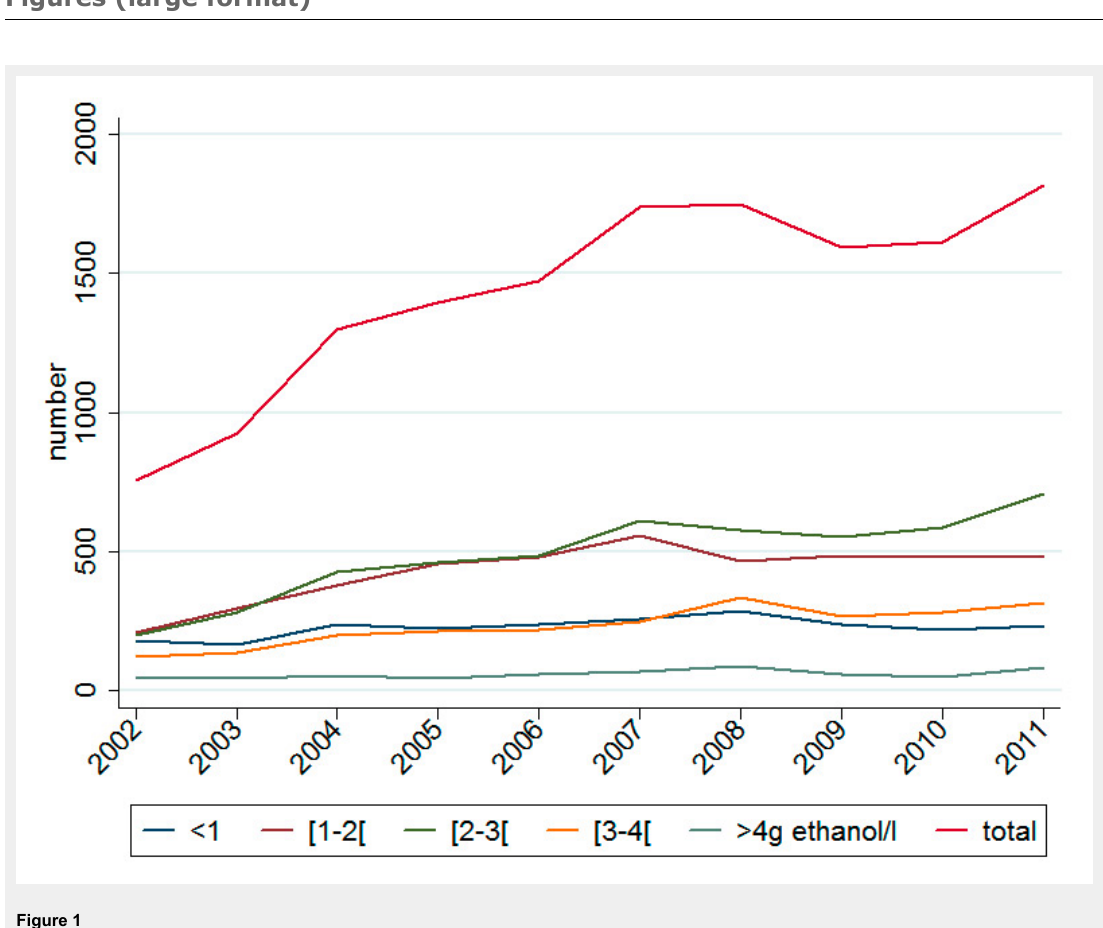
Total number of positive BAC ≤1, >1 to ≤2, >2 to ≤3, >3 to ≤4, >4 permille (g of ethanol per liter) over time. BAC: blood alcohol concentration A significant increase in the percentage of admissions with a positive BAC was observed over time (robust regression, coefficient (SE) for each year of observation = 0.0022 (0.0009), p = 0.04) corresponding to a 0.22% increase in the percentage of admissions with positive BAC each